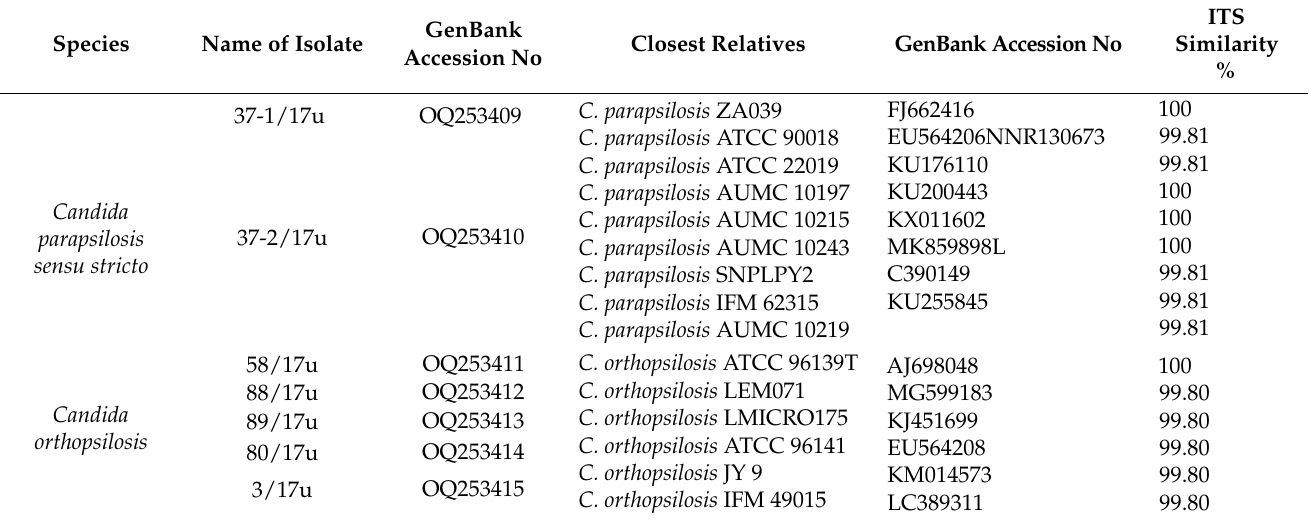
Table 3. Comparative analysis of ITS similarity between isolates derived from patient and GenBank, based on the neighbour-joining